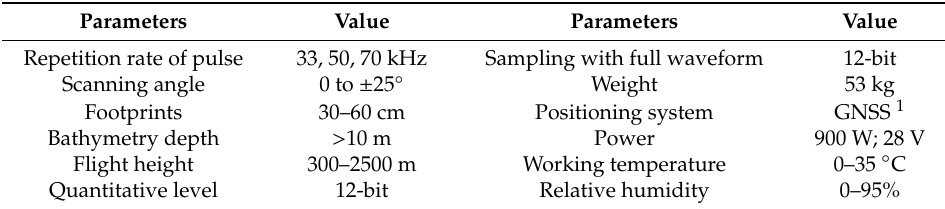
Table 1. The related parameters of the Aquarius bathymetry system.